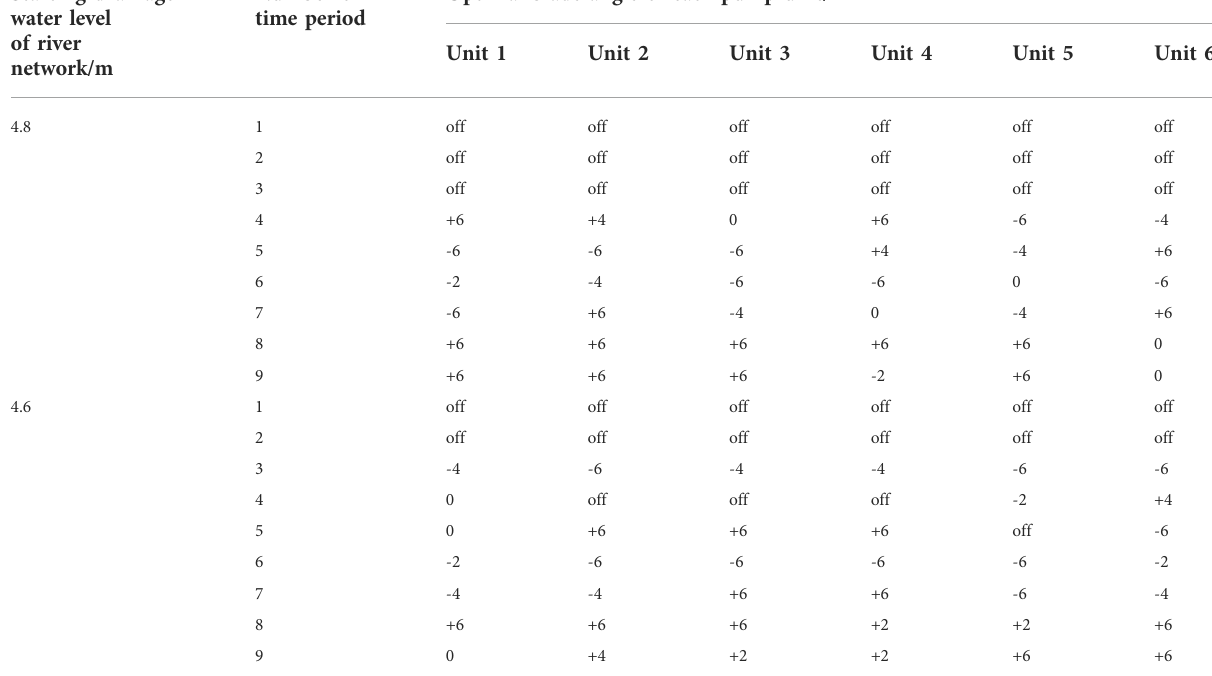
TABLE 2Optimizationschemes ofGuazhou pumpingstationunder different starting drainage waterlevels considering peak-valleyelectricity prices: Off means stop. Starting drainage water level of river